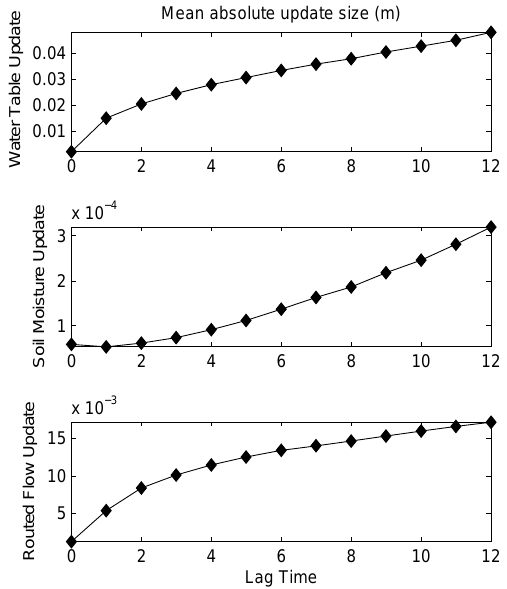
Fig. 13. Comparison of size of REnKF update by model state and lag time for the Pomahaka catchment, during the flood event shown in Fig. 8. Update values shown are the mean value over time and